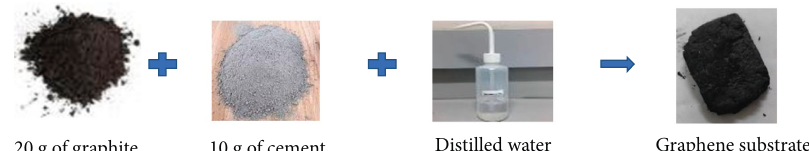
Figure 2: Preparation of graphene-cement substrate.